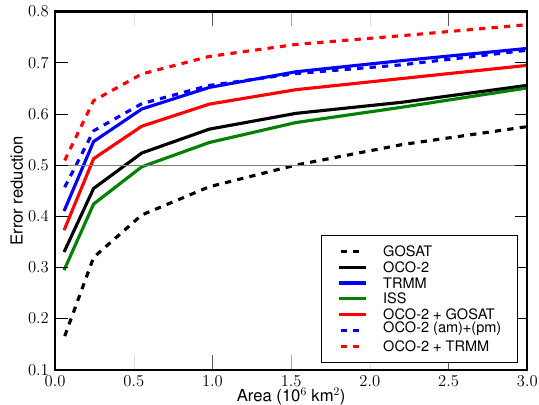
Fig. 6. The fractional error reduction γ of surface CO 2 fluxes over South America (15 ◦ S–15 ◦ N) during January 2003 as a function of spatial resolution: 0.05, 0.2, 0.5, 1.0, 1.5, 2.0, and 3.0 × 10 6 km 2 , respectively. We consider the error reduction using glint measurements from OCO-2 and GOSAT in sun-synchronous orbits, and for an OCO-2 SWIR spectrometer in the NASA TRMM and ISS orbits. The horizontal line denotes the γ =0.5